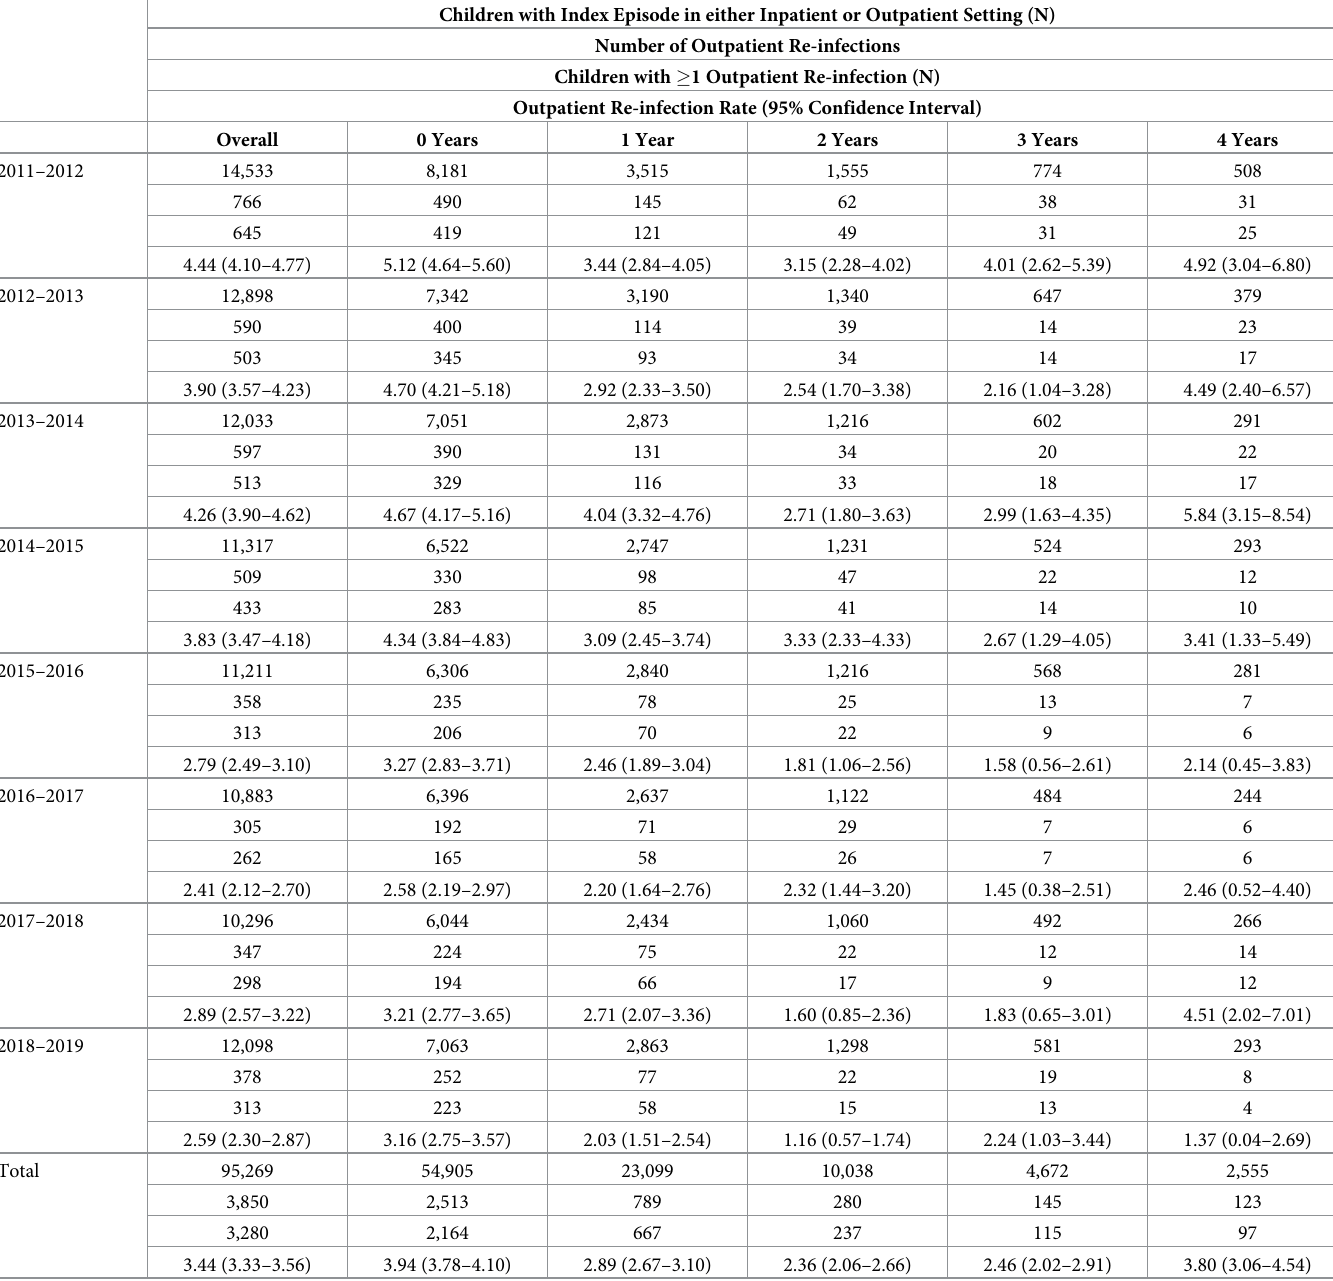
Table 2. Annual outpatient respiratory syncytial virus re-infection rate among commercially-insured children 0–4 years with an index inpatient or outpatient epi- sode in the same year, 2011–2019 a . Children with Index Episode in either Inpatient or Outpatient Setting (N) Number of Outpatient Re-infections Children with � 1 Outpatient Re-infection